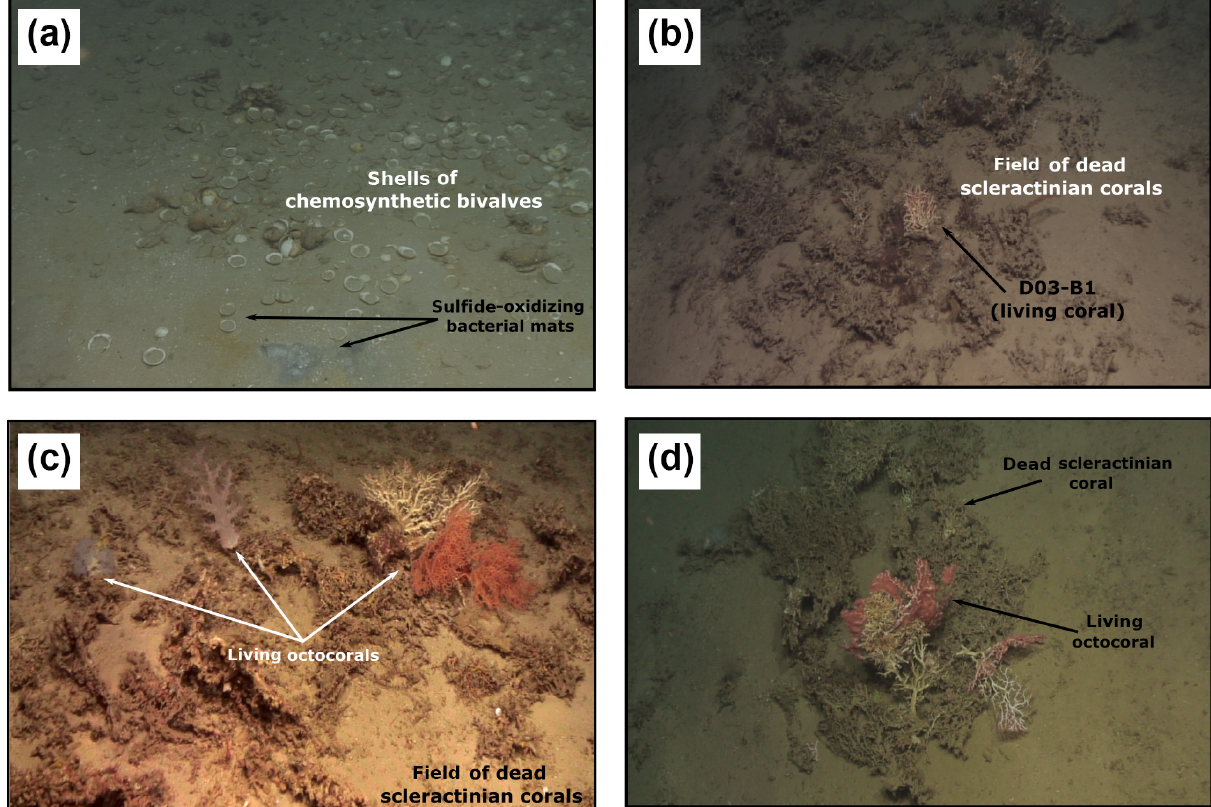
Figure 6. ROV still frames from the northern Pompeia Coral Ridge and extinct MV (Dive 03), where there is currently a diffused seepage of fluids. (a) Abundant shells of chemosynthetic bivalves with sulfide-oxidizing bacterial mats at the western site of the northern Pompeia Coral Ridge. b–d) Field of dead scleractinian corals colonized by living corals. (d) Still frame from the extinct MV.